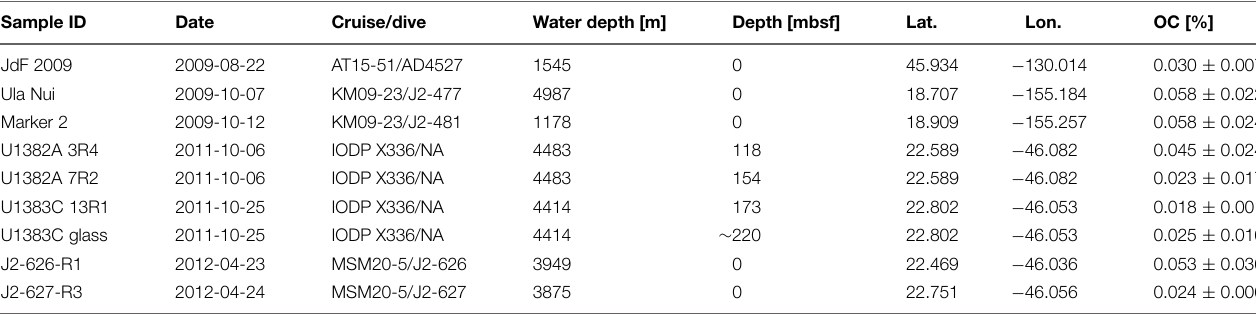
TABLE 1 | Characteristics of the basalt samples used in this study, including date of collection, cruise and dive number of collection, water depth of sample, depth below seafloor, latitude, longitude, and weight percent organic carbon (OC; listed as average ± 1 standard deviation; n =